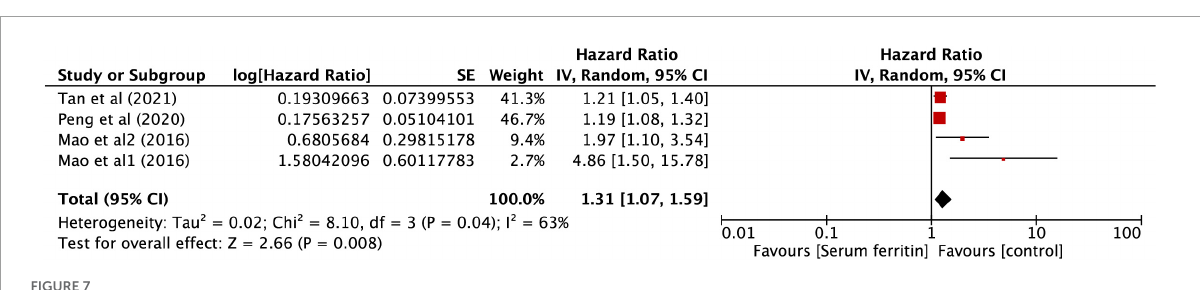
FIGURE7 Forest plots of hazard ratios for the association between expression of SF for KD in four